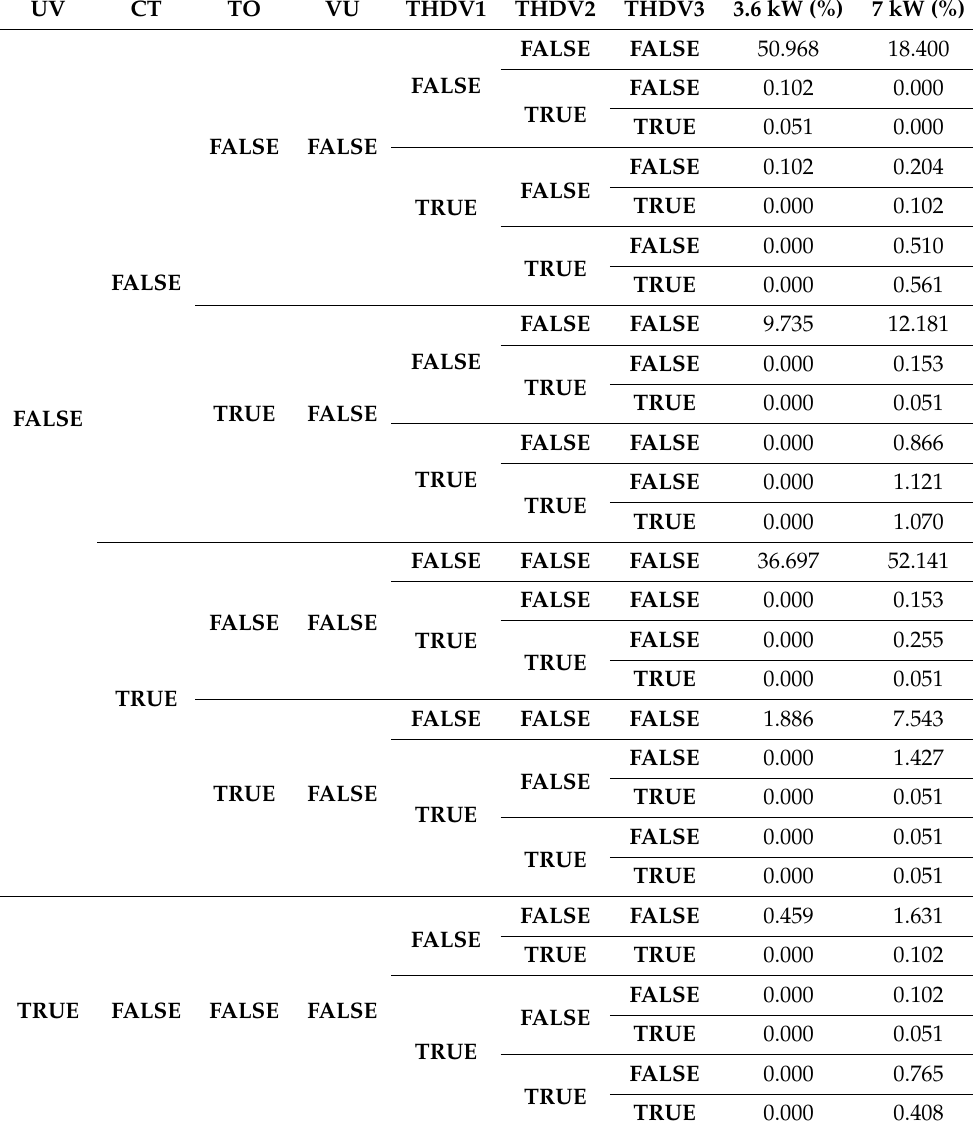
Table 5. Summary of violations in Feeder